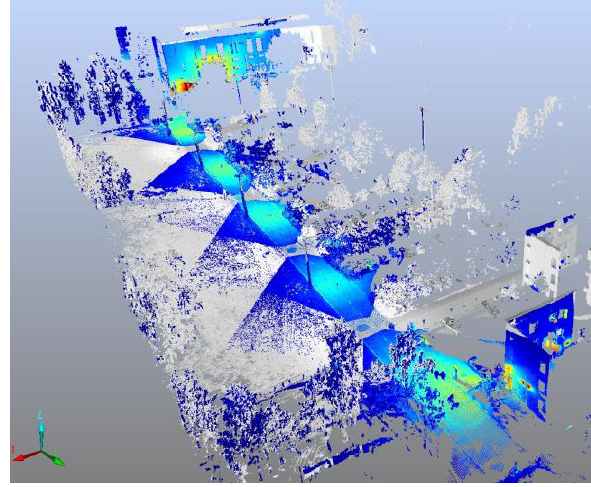
Figure 9. Luminance measurement integrated into TLS.